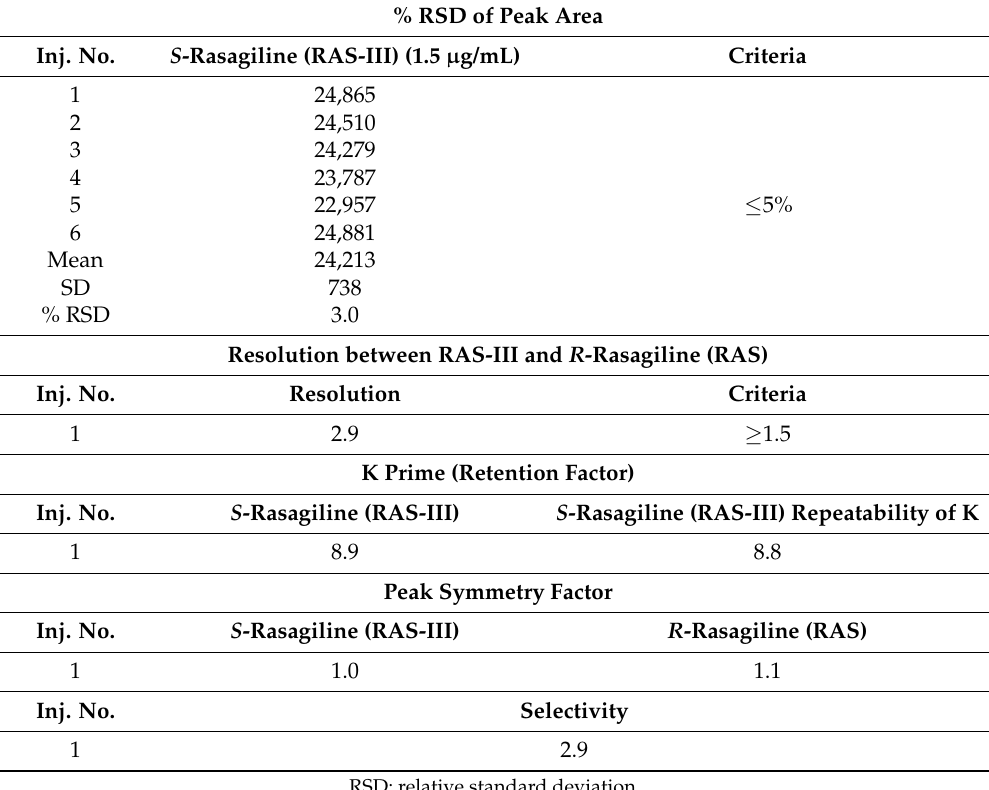
Table 2. Determination of the system suitability and precision.